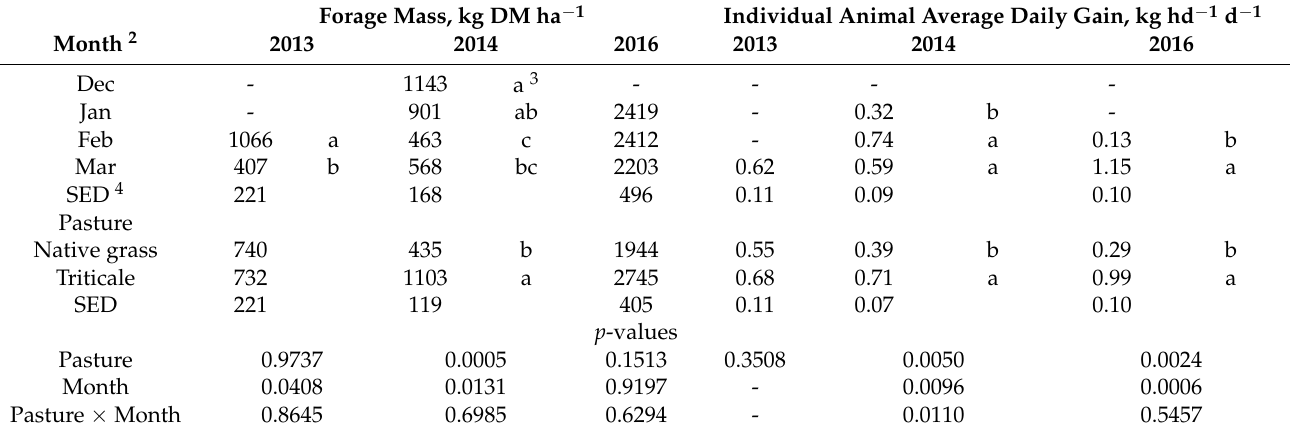
Table 3. Monthly forage dry matter (DM) mass of native grass or triticale pastures grazed by growing beef cattle and average daily gain during the late winters of 2013, 2014, and 2016 1 at Tucumcari, NM, USA. Values are the means of two pasture replicates within each